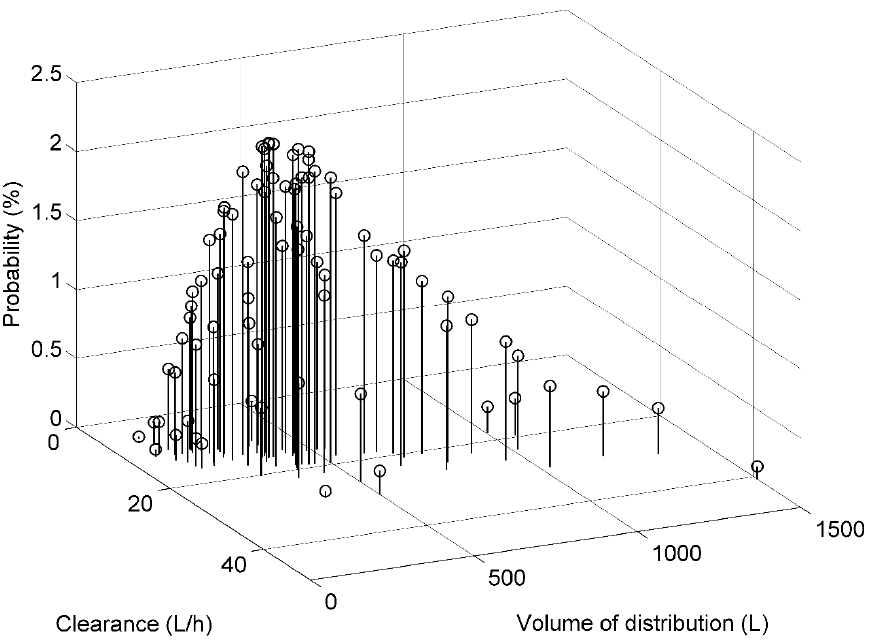
Figure 1. Discrete prior distribution of imatinib clearance and volume of distribution in a typical patient. The patient is a male with CML, his age and body weight are 50 years and 70 kg, respectively. The nonparametric, discrete PK model can be used to calculate a priori Cmin distribu- tion for various imatinib dosage regimens. Let us take the example of a virtual patient, a 60-year-old woman weighing 60 kg, with CML. Based on Equations (1) and (2), her median a priori values of CL and V are 11.7 L/h and 300.8 L, respectively. However, using